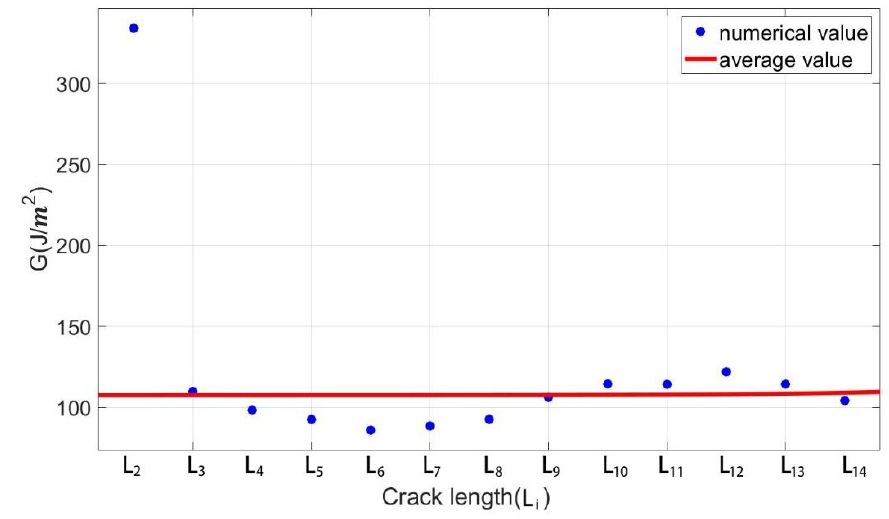
Figure 10. Relationship between the energy release rate ( 𝐺 𝐼𝐶 ) and L i in the Chinese fir DCB